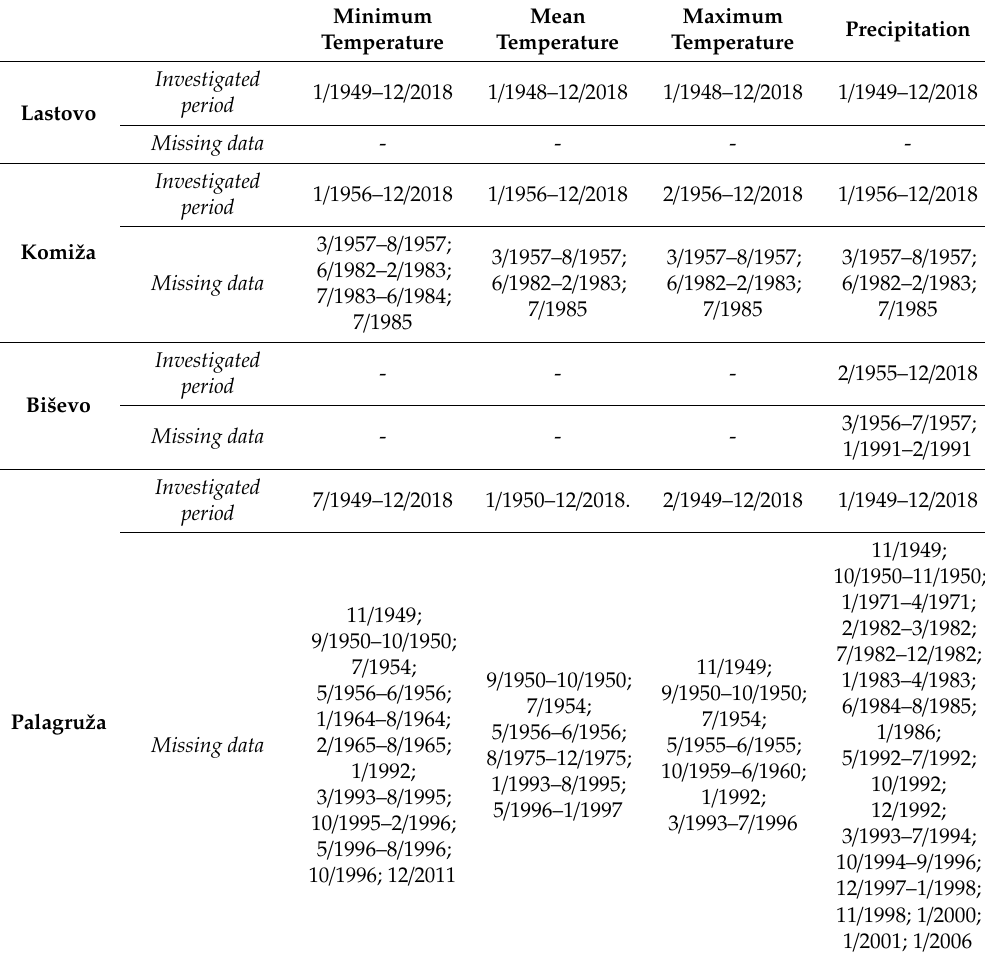
Table 2. Available time series of data used within this